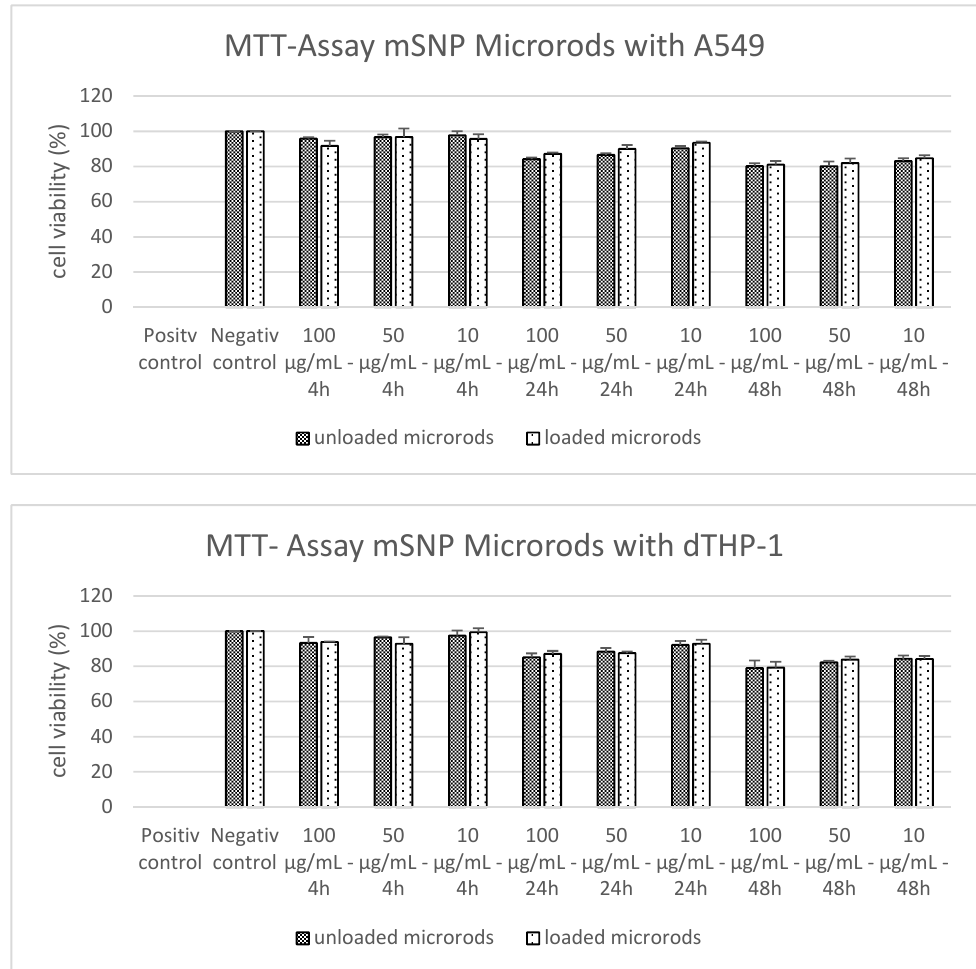
Figure 4 . Determination of cell viability after incubation of the human alveolar epithelial cell line A549 (upper graph) and the differentiated human macrophage cell line dTHP-1 (lower graph) with unloaded and curcumin + siRNA loaded microrods. Incubation times of 4 to 48 h were chosen with a concentration of 10, 50 and 100 µg/mL. These parameters were adjusted to those of the ELISA performed later to see if the conditions are suitable for cytokine determination, as toxicity would cause high cytokine levels. Up to 48 h incubation time, no relevant toxicity can be observed.